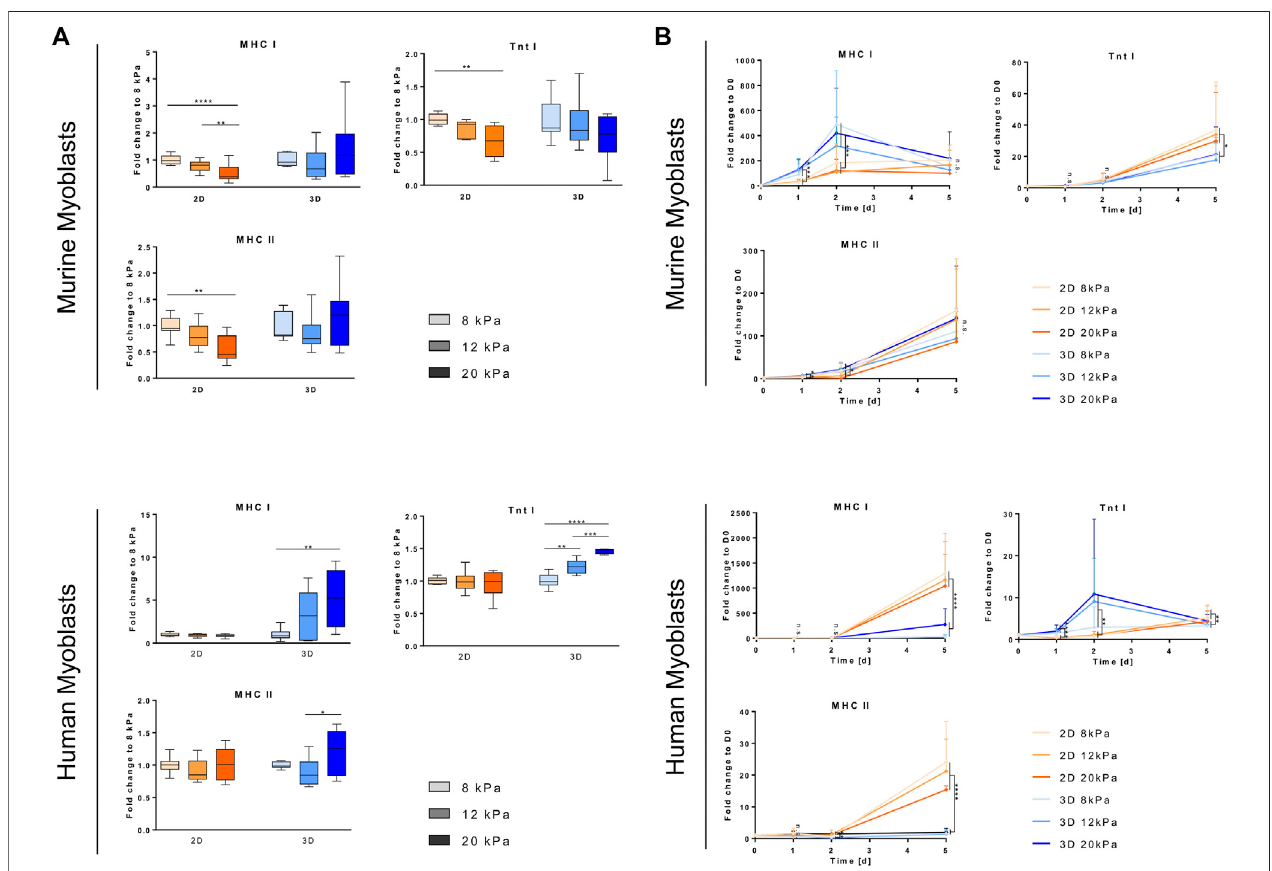
FIGURE2| Substratestiffnessandarchitectureaffectmyoblastproliferation.Murineandhumanmyoblastswereculturedon fi brin-coatedcellcultureplates(2D)or encapsulatedin fi brinhydrogels(3D)withdifferent fi brinogen(Fbg)concentrations(5,10and20 mg/ml)for4 daysunderproliferativeconditions.DNAcontentofsamples wasassessed byHoechst staining. (A) DNA content ofeach fi brinogenconcentration (5, 10 and 20 mg/ml), culture set up(2D and 3D)and cell type (murine and human myoblasts) was normalized to their respective D0 values (dotted line indicates D0 level). Data is shown as box and whiskers (min to max); N ≥ 2, n ≥ 6; one-way ANOVAwithTukey ’ smultiplecomparisontestwasperformedcomparingall fi brinogenconcentrationsofeachdaywitheachother,* p < 0.05,** p < 0.01,**** p < 0.0001. (B) DNAcontentof all fi brinogenconcentrations (5, 10 and 20 mg/ml) ofeach culture set up (2Dand 3D) and cell type (murine and human myoblasts) wasnormalized